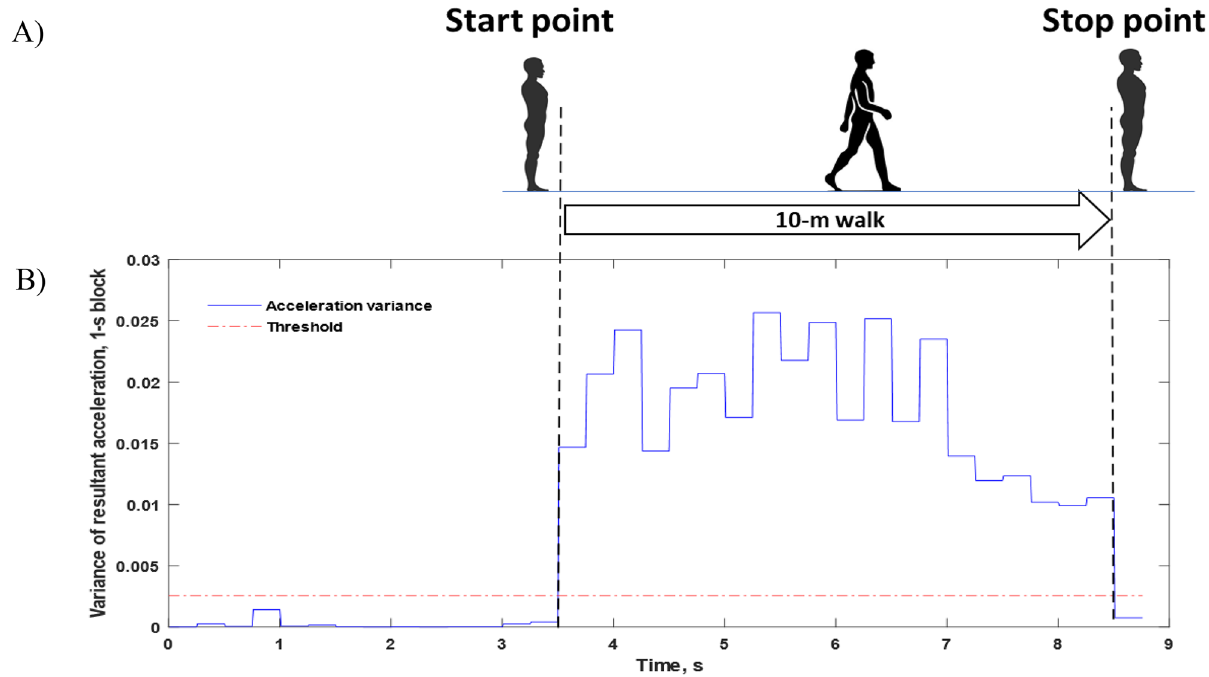
Figure 2. Ten-Meter Walking Speed Protocol and Gait Analysis. ( A ) Gait speed assessment is initiated automatically as the participant takes a step from standing still. After the participant steps completely over the 10-m marker and stands still again, the assessment is completed. ( B ) Acceleration signals the moving window (0.5 s) variance of low-pass-filtered resultant acceleration, which was used to calculate the gait